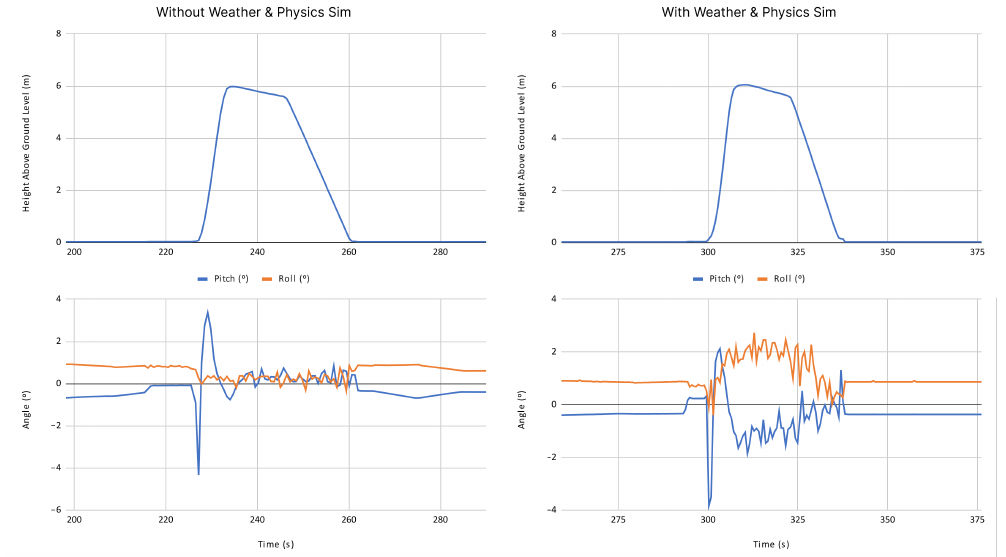
Figure 10. Short flight comparison of pitch and roll angles with and without our custom weather and physics